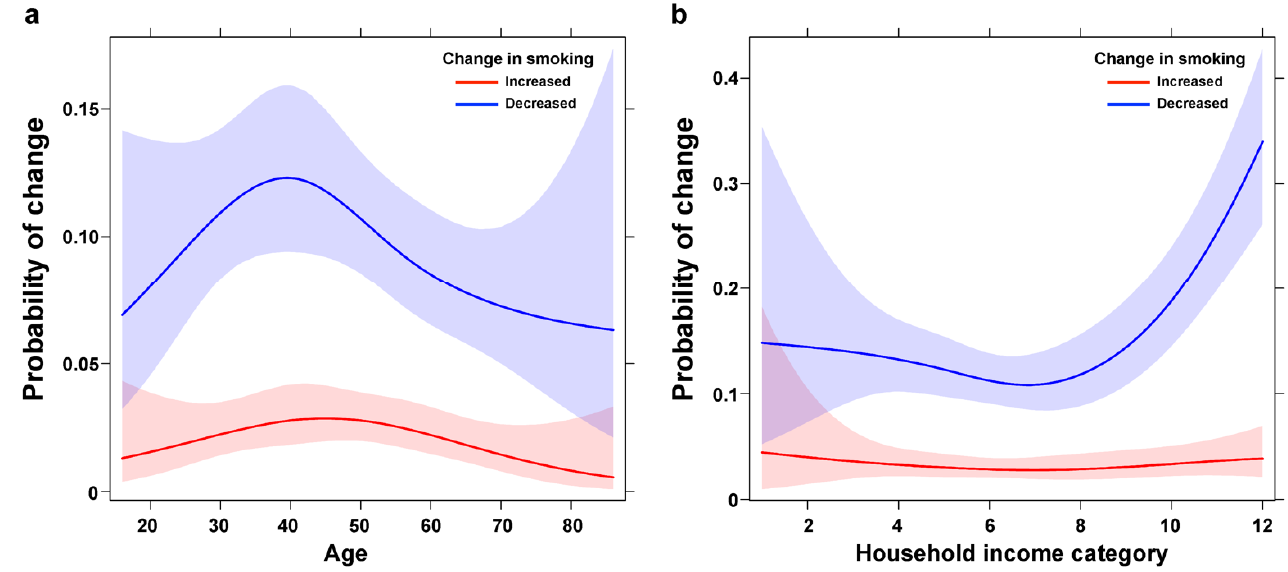
Figure 2. Probability of changes in smoking by ( a ) age and ( b ) household income in restricted cubic spline function. The probability of decreasing the smoking amount during the COVID-19 pandemic is higher for those with higher household income. Table 2. Multinomial logistic regression results for the associations between various factors and changes in smoking and alcohol